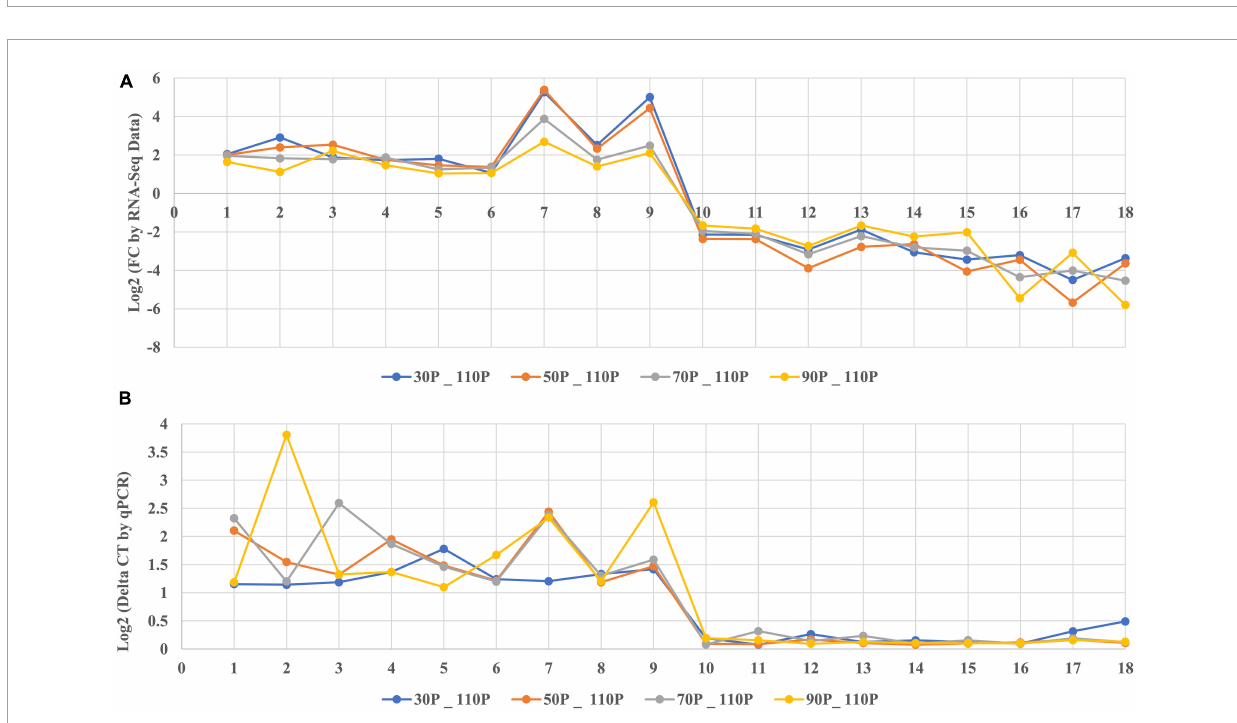
FIGURE6 Quantitative RT-PCR analysis of selected genes. (A) Log2 fold change determined by RNA-seq, (B) Log2 fold change determined by qRT-PCR. Different colors represent the fold changes from different samples: blue, 30P_110P, orange, 50P_110P, gray, 70P_110P, yellow, 90P_11P. Numbers 1 to 18 represent genes Hypma_015692 , Hypma_006925 , Hypma_006711 , Hypma_013322 , Hypma_015185 , Hypma_002213 , Hypma_013537 , Hypma_001039 , Hypma_012178 , Hypma_011936 , Hypma_012533 , Hypma_005024 , Hypma_014954 , Hypma_012995 , Hypma_003453